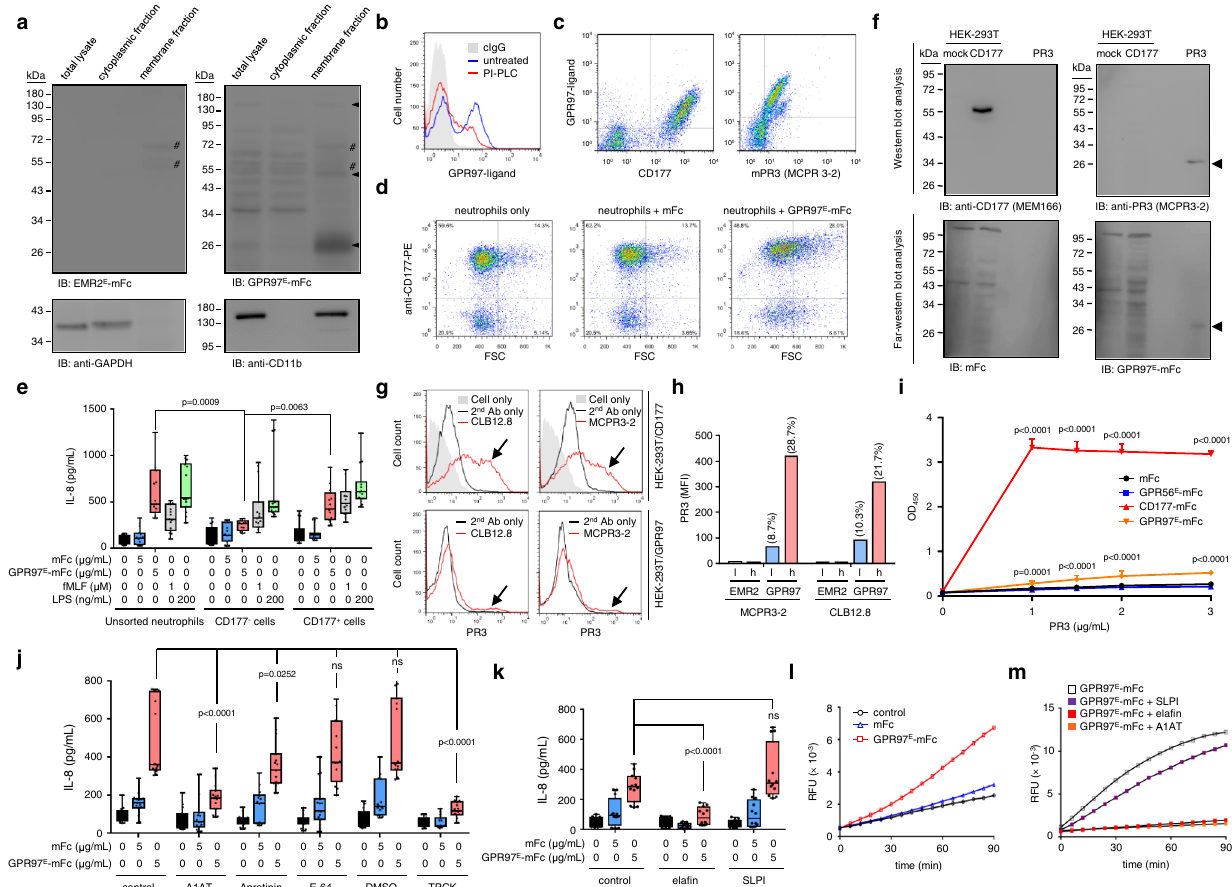
Fig. 3 | GPR97 is a binding partner and allosteric activator of mPR3. a Far- western blot analyses of the putative GPR97-ligand(s)(black arrowheads). The EMR2 E -mFcproteinwasusedasanegativecontrol.Anti-CD11bandanti-GADPHAbs detected the corresponding protein markers of the membranous and cytoplasmic fractions, respectively. #, non-speci fi c signals. Experiments were repeated 3 times with similar results. b FACS-based ligand-binding analysis of neutrophils pre- treated without or with phosphoinositide phospholipase C (PI-PLC). c Dot-plots of neutrophils double-stained with GPR97 E -mFc and anti-CD177 or anti-PR3 mAb. d Dot-plots (FSC vs. surface CD177 levels) of neutrophils incubated with GPR97 E - mFc. e IL-8 produced by unsorted and sorted neutrophils incubated with various reagents as indicated. n =5 independent experiments. Cells treated with fMLF and LPS were included as positive controls. f Far-western blot analysis of speci fi c GPR97-PR3binding.Samplesincludedtotallysatesofmock-andCD177-transfected HEK-293Tcellsaswellaspuri fi edPR3.Thearrowheadsindicatedthespeci fi csignals